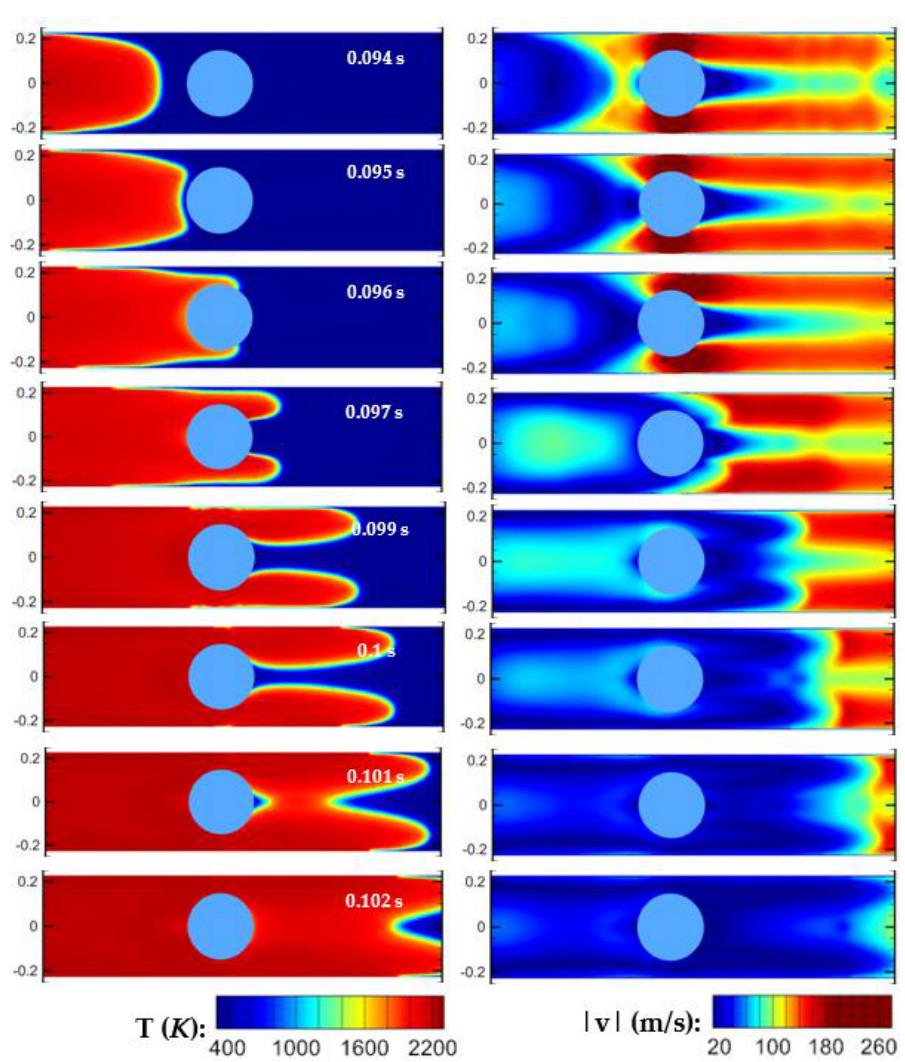
Figure 10. Moment when the flame propagates across the half-inflated obstruction. Left: flame profile; right: velocity contour. The obstruction is installed at x = 10 m and half inflated.